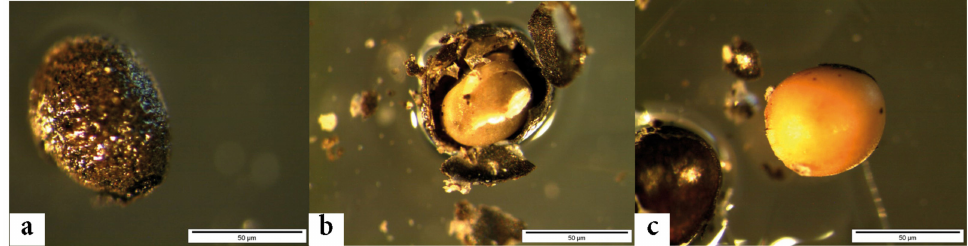
Figure 6. Removal of Brassica seed integument: ( a ) seed with integer integument, ( b ) seed with cracked integument, ( c ) seed without integument. Photographs: S. De